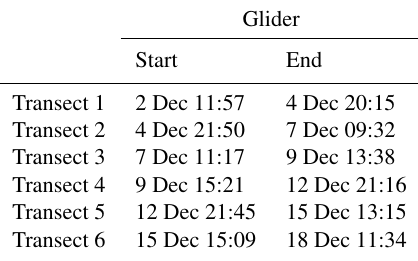
Table 1. Dates of glider transects.